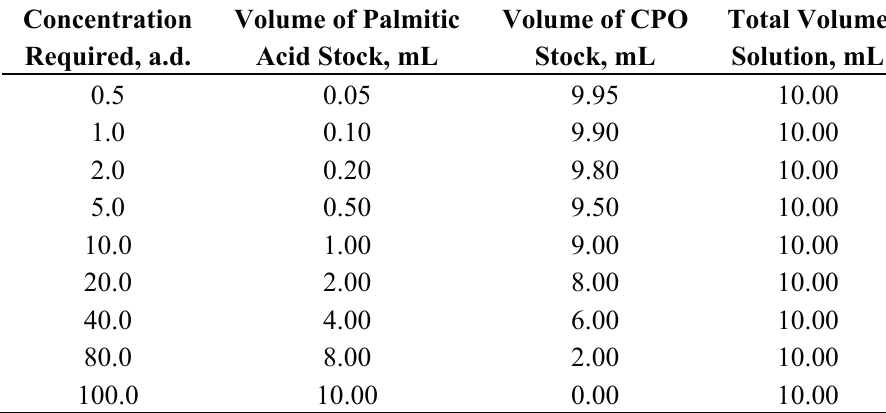
Table 1. Sample preparation for the calibration